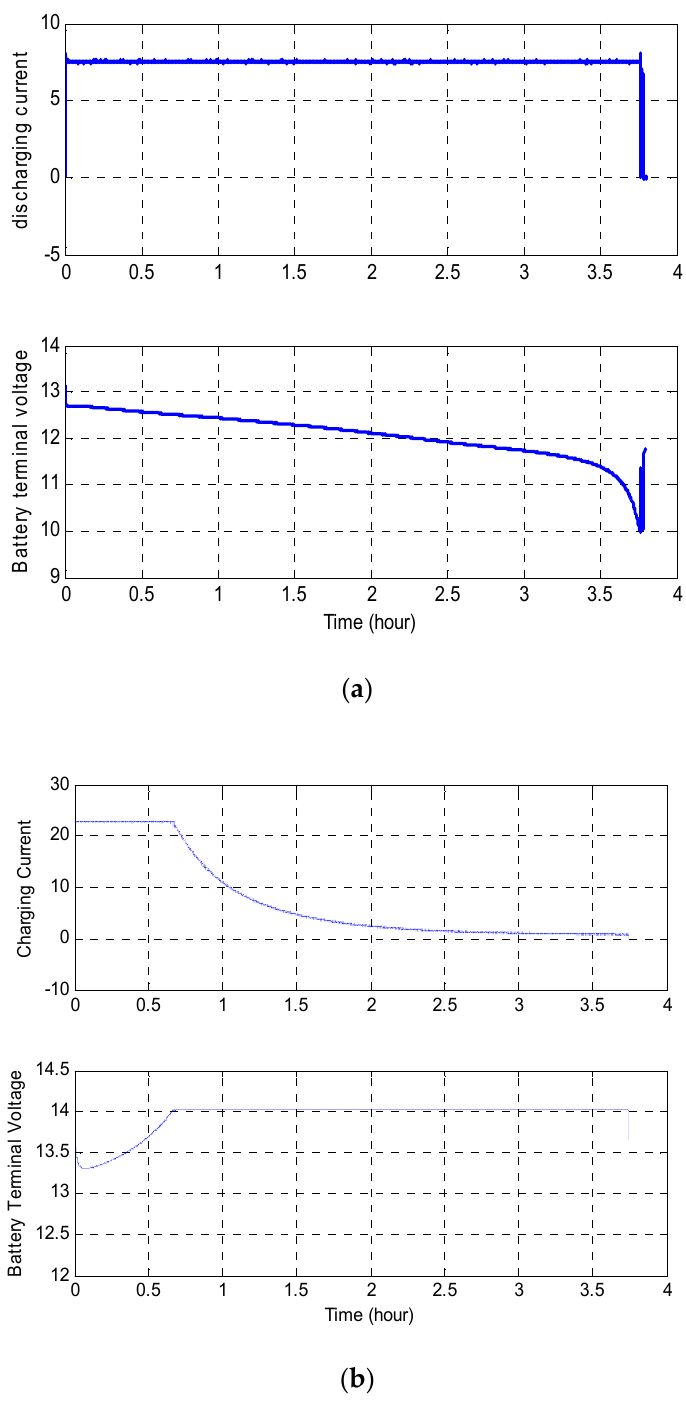
Figure 16. ( a ). Current and voltage waveforms for a capacity measurement test; ( b ) current and voltage waveforms for a battery charging event.